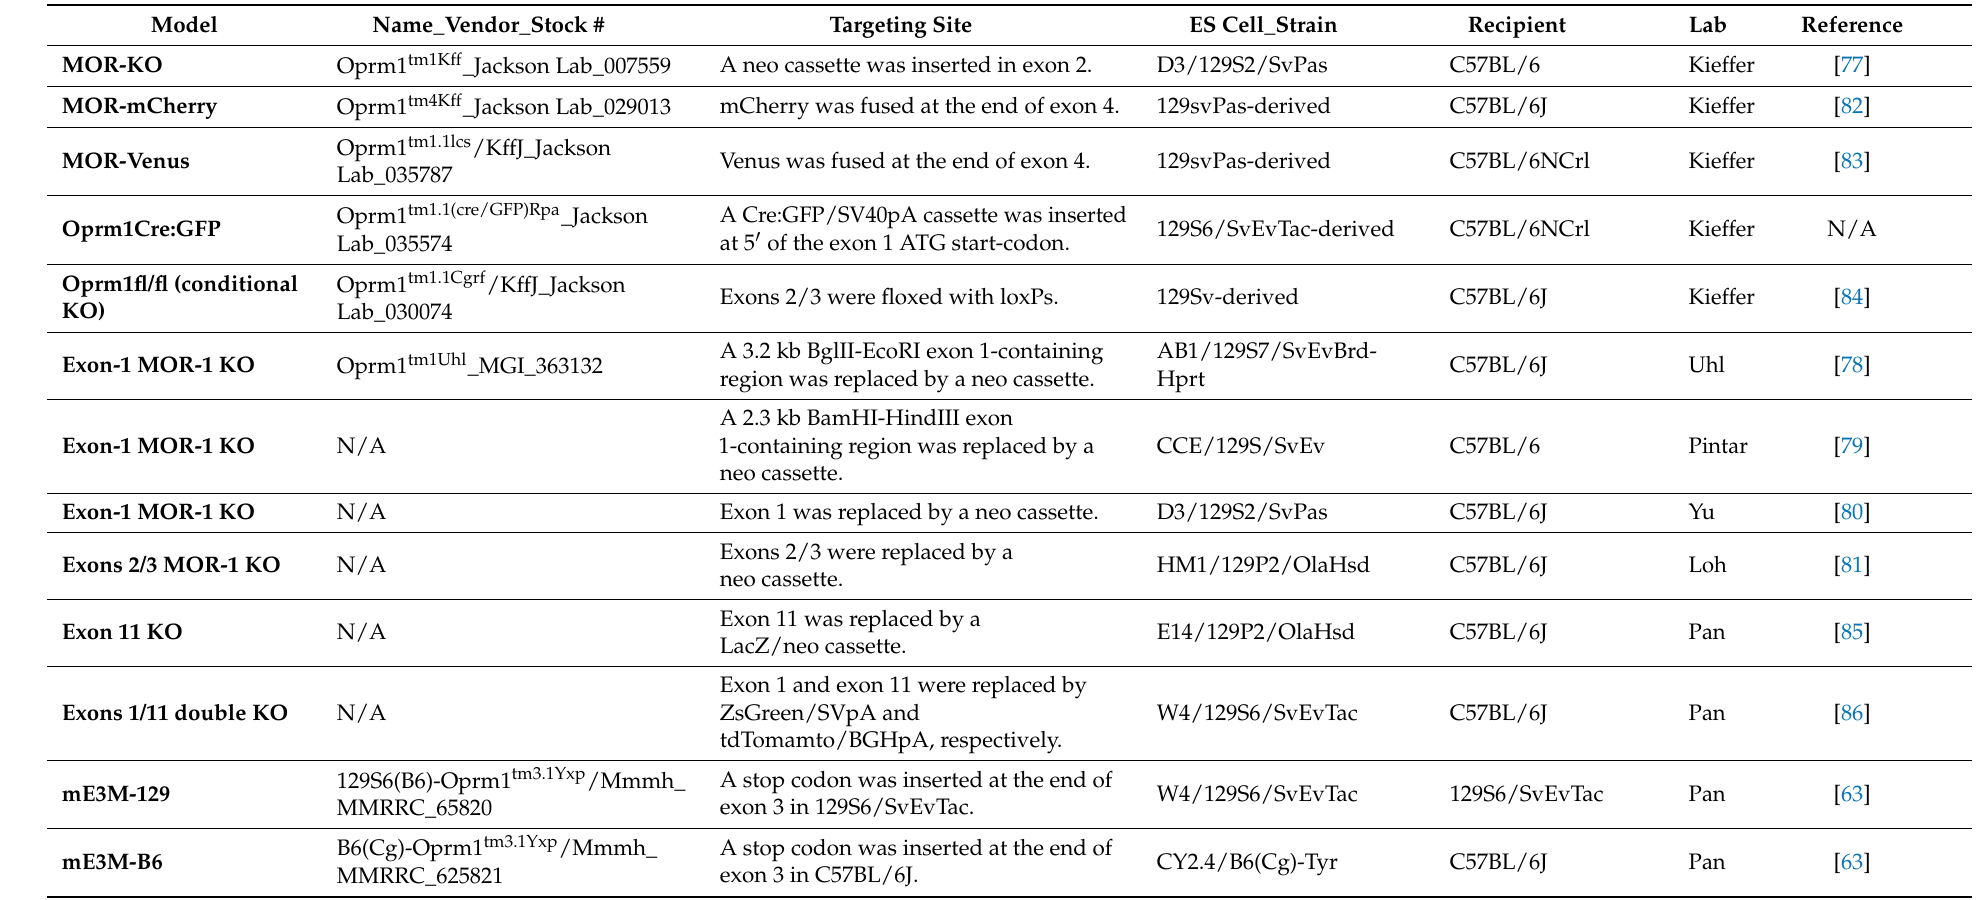
Table 1. List of the Oprm1 -targeted mouse